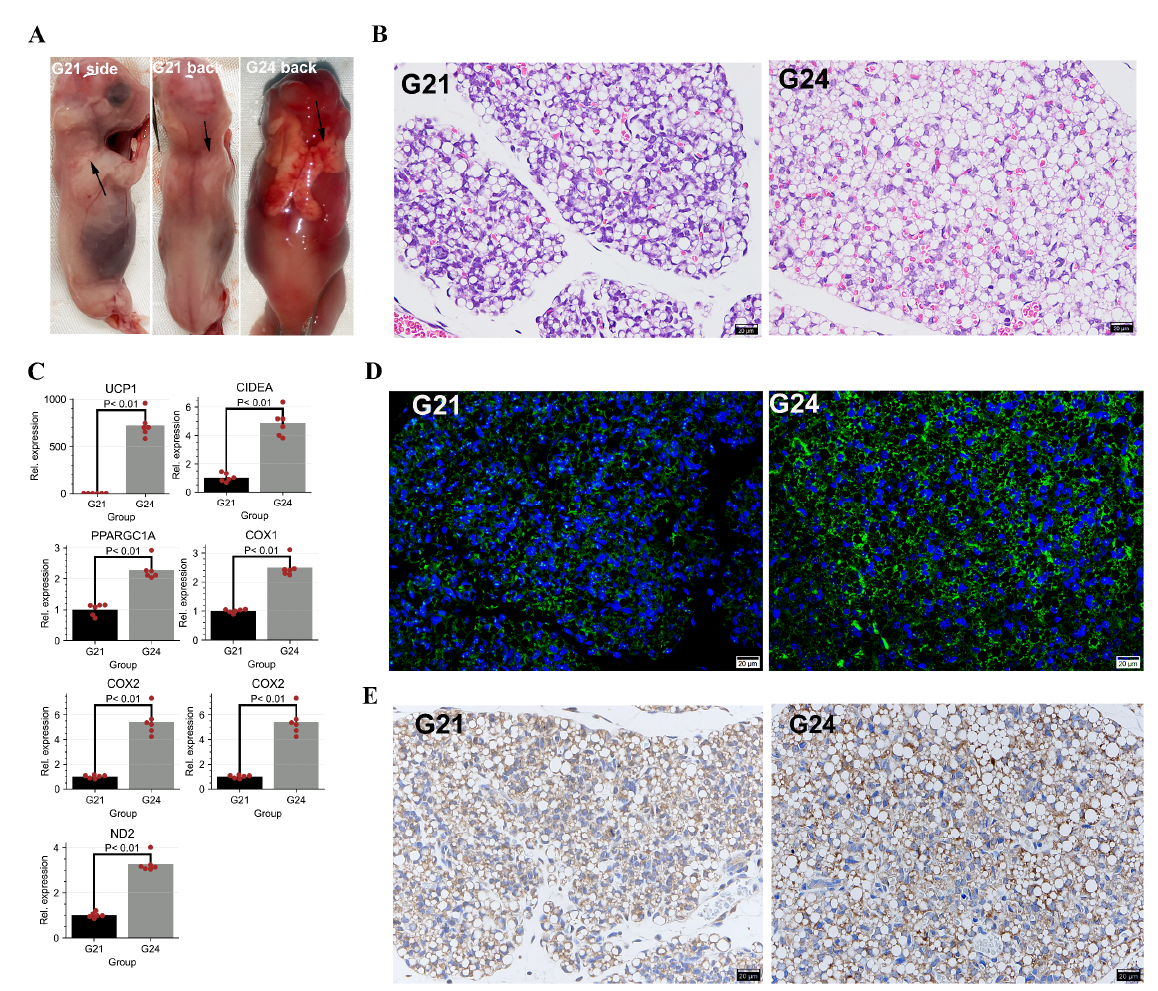
Figure 1. Histological analyses of the early development of fetal BATs (FBATs). ( A ) Rabbit FBATs in gestational day 21 (G21) and gestational day 24 (G24). The arrows show the FBAT depots. ( B ) H&E staining of rabbit FBATs. The scale bars: 20μm. The blue signals show the cell nucleus. ( C ) RT-qPCR detects mRNA expression levels of UCP1, CIDEA, PPARGC1A, COX1, COX2, ND1, and ND2. The bar shows the means of 6 independent experiments. Two technical replicates were set for one individual experimental replicate. The “Rel.” represents “Relative”. The expression is normalized to the RN18S and G21. Each red dot shows the relative expression level of one experimental replicate. ( D , E ) Uncoupling protein 1 (UCP1) immunofluorescence (IF) and immunohistochemical (IHC) of rabbit FBATs. The scale bars: 20μm. The blue signals show the nucleus. The green signals and brown signals show the expressed UCP1 proteins in IF and IHC, respectively.